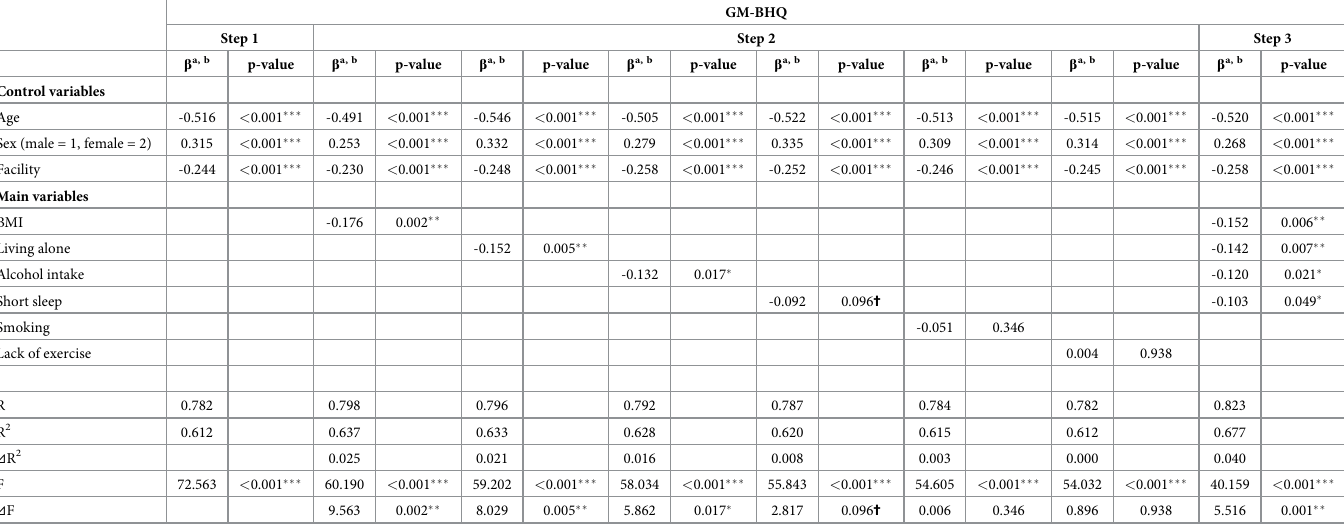
Table 3. Multiple regression analysis of unhealthy lifestyle factors on